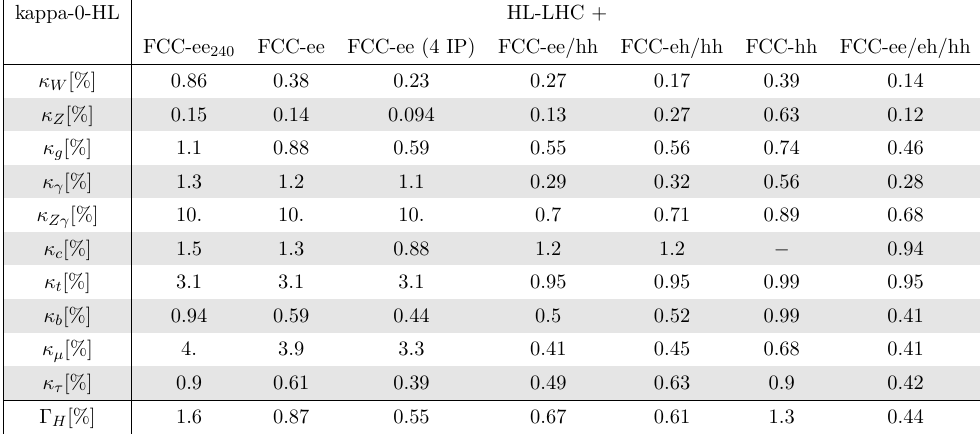
Table 30 . Results of kappa-0-HL (cid:12)t for various scenarios of the FCC. In all cases the FCC data are combined with HL-LHC. The \4 IP" option considers 4 experiments instead of the 2 experiments considered in the CDR. For the FCC-hh scenario constraints on the b , (cid:28) and W couplings come from measurements of ratios of WH to WZ production with the H and Z decaying to b -quarks or (cid:28) leptons, see ref. [139].